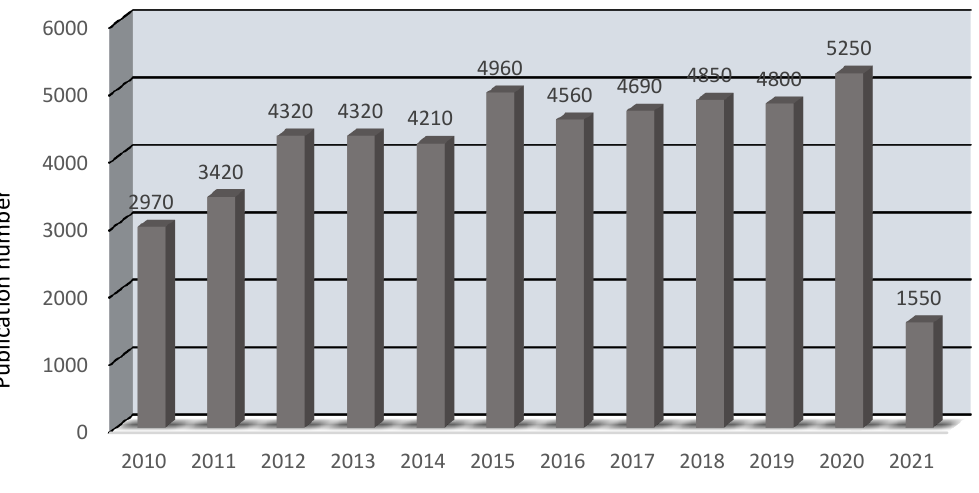
Figure 2. A brief post-2010 timeline depicting the number of associated academic publications for the acid retrieved through diffusion dialysis process with anion exchange membranes (Available online: Google Scholar (12 December 2021).